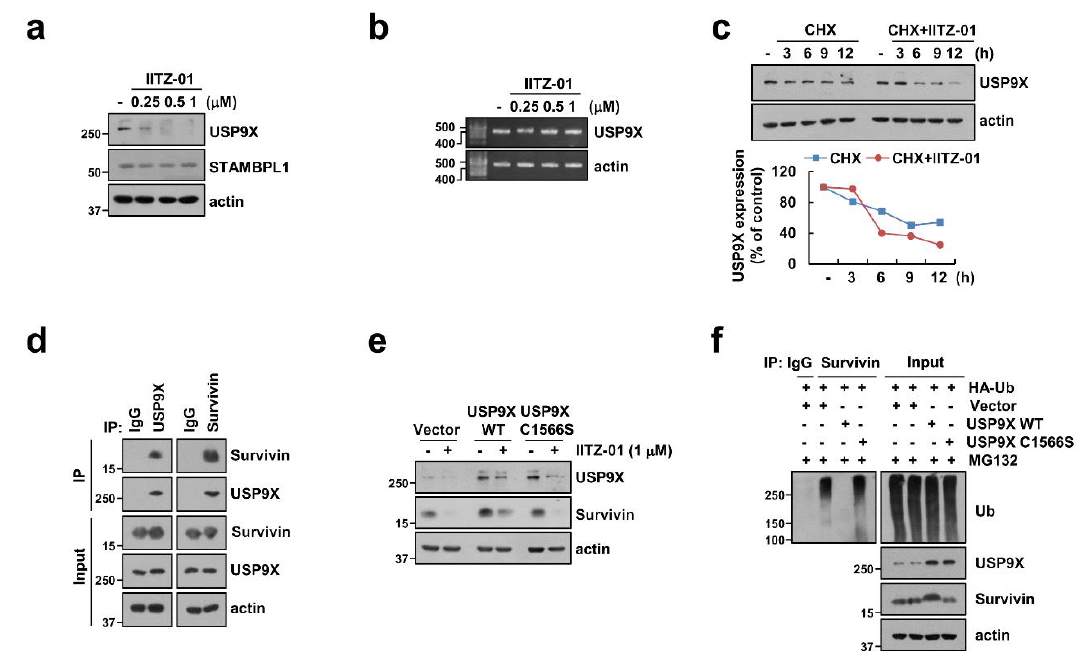
Figure 6. Degradation of survivin is critical to induction of IITZ-01 plus TRAIL-induced apoptosis through downregulation of USP9X. ( a , b ) Caki-1 cells were incubated with 0.25–1 µ M IITZ-01 for 18 h. USP9X mRNA levels were determined by RT-PCR; ( c ) Caki-1 cells were incubated with 20 µ g / mL CHX and / or 1 µ M IITZ-01 for the indicated time periods. The band intensity of the USP9X protein was measured using Image J; ( d ) The interaction with survivin and USP9X was indicated by immunoprecipitation (IP) assay; ( e ) Caki-1 cells were transiently transfected with pDESTS1 (Vector), pDESTS1-USP9X (USP9X WT) or pDESTS1-USP9X / C1566S (USP9X C1566S), and then incubated with 1 µ M IITZ-01 for 18 h; ( f ) To analyze the ubiquitination of endogenous survivin, Caki-1 cells were transfected with HA-ubiquitin (HA-Ub), USP9X WT and USP9X C1566S and treated with 0.5 µ M MG132. Cells were lysed in 1% sodium dodecyl sulfate (SDS) bu ff er to disrupt interacting proteins and cell lysates were then diluted to 0.1% SDS, followed by the immunoprecipitation using an anti-survivin. Survivin ubiquitination was detected by Western blotting using an horseradish peroxidase (HRP)-conjugated anti-Ub antibody. The protein levels were analyzed by Western blotting ( a , c – f ).